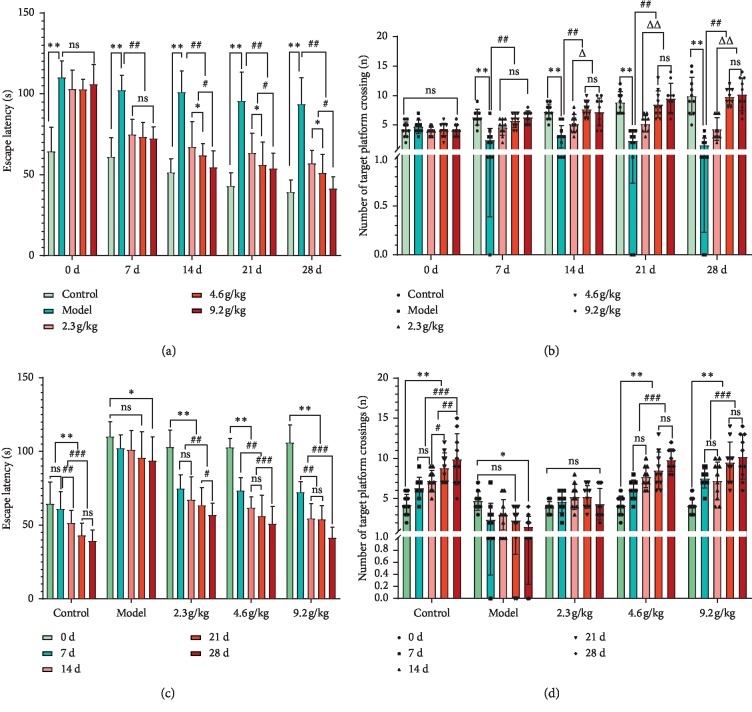
Learning and memory ability after the administration of SCPE. (a) Dose-effect relationship of the navigation experiment. (b) Dose-effect relationship of the space exploration experiment. (c) Time-effect relationship of the navigation experiment. (d) Time-effect relationship of the space exploration experiment. The data are shown as the mean ± SD of 10 mice per group; ∗∗versus the control group, P < 0.01 (a, b); ##versus the model group, P < 0.01 (a, b); ∗versus the low-dose group, P < 0.05 (a); #versus the low- and medium-dose groups, P < 0.05 (a); Δversus the low-dose group, P < 0.05 (b); ΔΔversus the low-dose group, P < 0.01 (b); ∗∗versus the day 0, P < 0.01 (c, d); ∗versus the day 0, P < 0.05 (c, d); ##versus the 7th day, P < 0.01 (c, d); ###versus the 28th day, P < 0.01 (c, d). Ns: not significant.